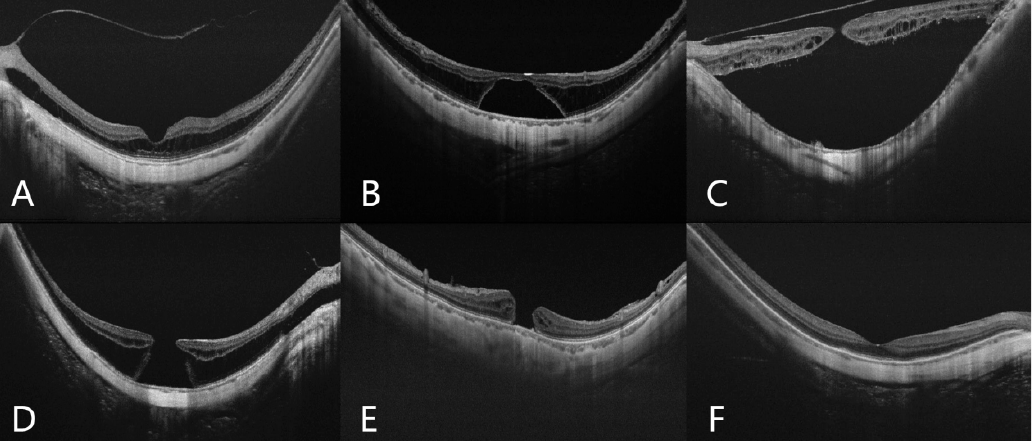
Figure 1. Typical SS-OCT images of highly myopic eyes with different types of MTM. ( A ) Foveoschisis; ( B ) foveal detachment; ( C ) macular hole retinal detachment; ( D ) macular hole with foveoschisis; ( E ) macular hole without foveoschisis; ( F ) no MTM.